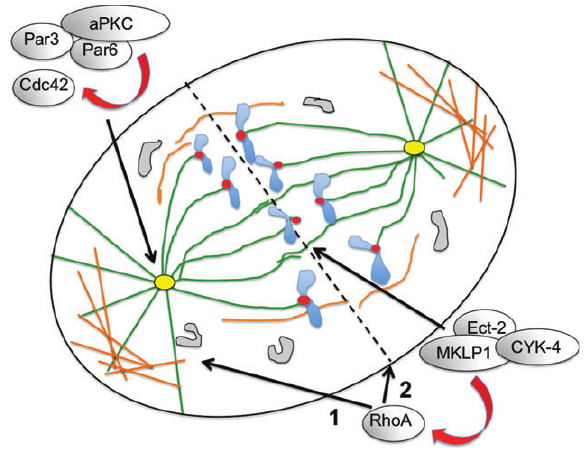
Figure 3 Rho GTPases, cell polarity, and mitosis. RhoA is involved early in mitosis (1) to induce cortical retraction and cell rounding, probably through mobilization of actin (orange), then to orientate the mitotic furrow, and later, to induce the formation of the contractile ring (2) at the cell equator (dashed line). A complex called central spindlin, localized at the spindle midzone and cata- lyzes microtubule bundling (green), activates RhoA. This contains a kinesin-like protein (MKLP1), a Rho GTPase-activating protein (CYK-4/MgcRacGAP) and the ECT2 Rho GEF, likely responsible for the translocation of active RhoA to the equatorial cortex. RhoA recruits locally citron kinase, which phosphorylates MRLC, thus promoting actomyosin assembly. Actin localizes also to the mitotic spindle in cables, wrapping it and extending to the cortex. Cdc42 interacts with Par3, Par6, and aPKC, which are parts of the polarity complex, and is involved in the interaction of radial asters with the cortex to position the apical pole of epithelial cells. It is also likely to participate to functional interactions between the centrosome and the Golgi apparatus, which is fragmented during mitosis (gray